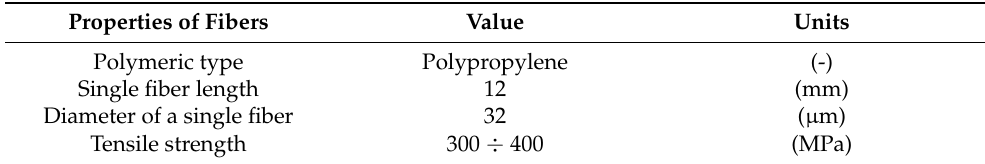
Table 3. Properties of polypropylene